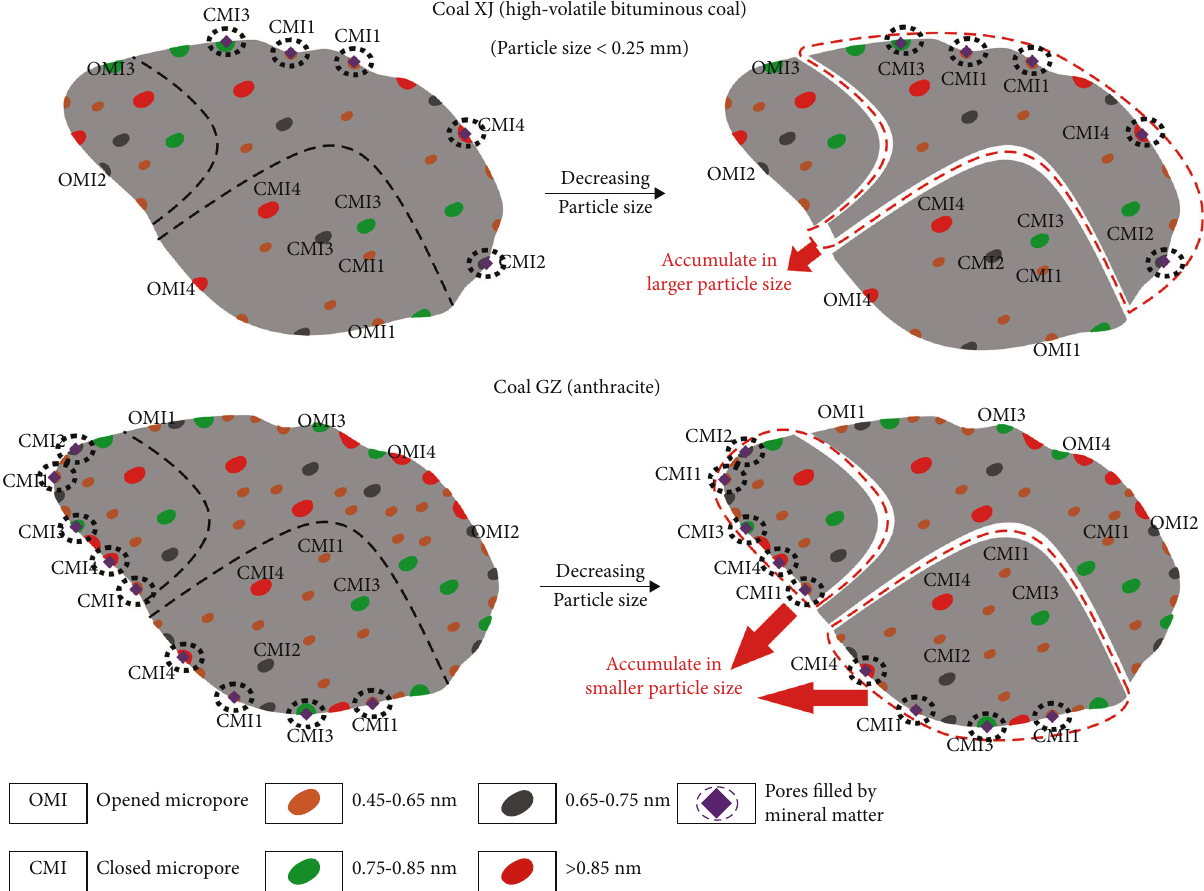
Figure 13: Evolution model of micropore structure during the crushing process of Coal XJ and Coal